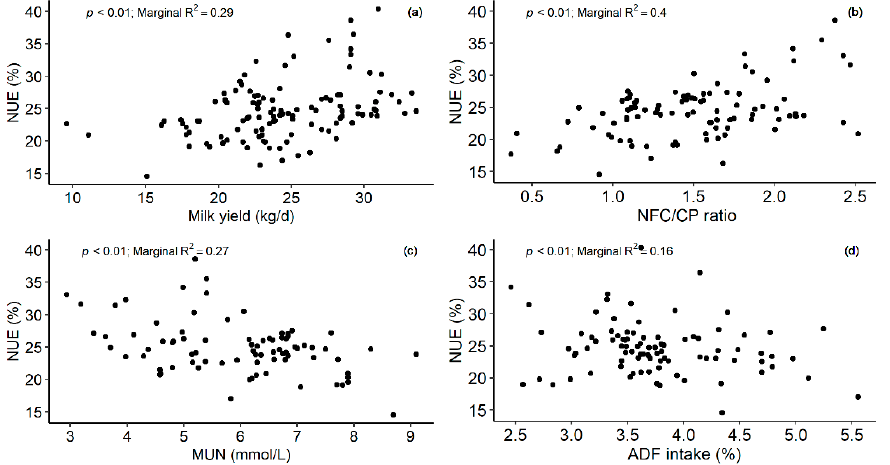
Figure 3. Relationship between nitrogen use efficiency (NUE) and ( a ) Milk yield; ( b ) non-fibrous carbohydrates/crude protein (NFC/CP) ratio; ( c ) Milk urea nitrogen (MUN); and ( d ) acid detergent fiber (ADF) intake of the diet in dairy cattle.